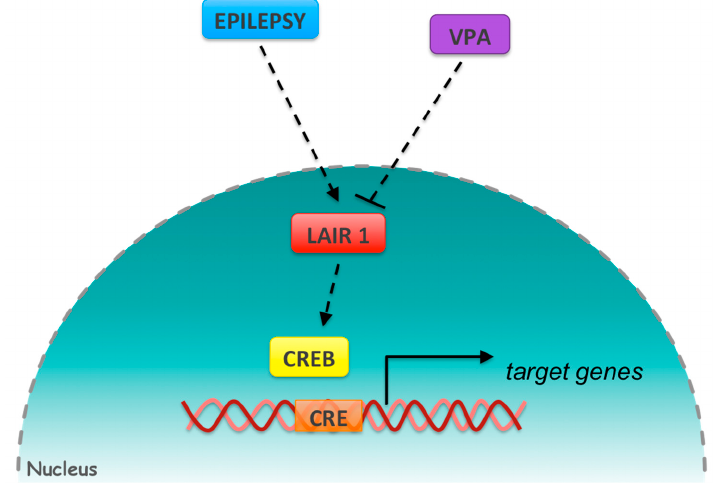
Figure 6. Image depicting a possible model of action for VPA in generalized epilepsy on gene expression through the LAIR1-CREB axis.